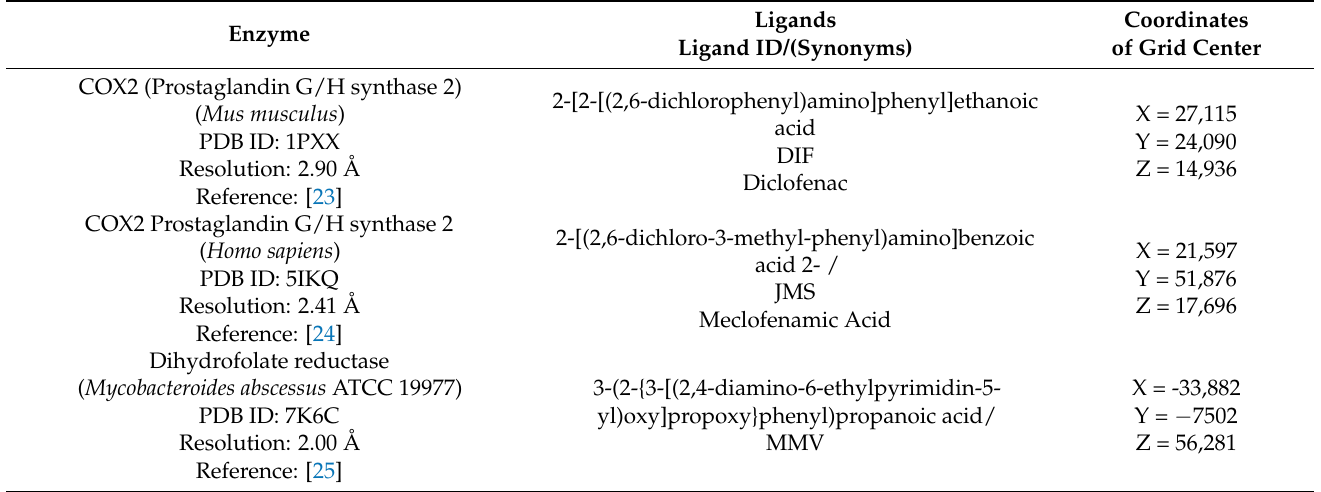
Table 8. Description of receptors related to antibacterial and anti-inflammatory activity used in the study of molecular